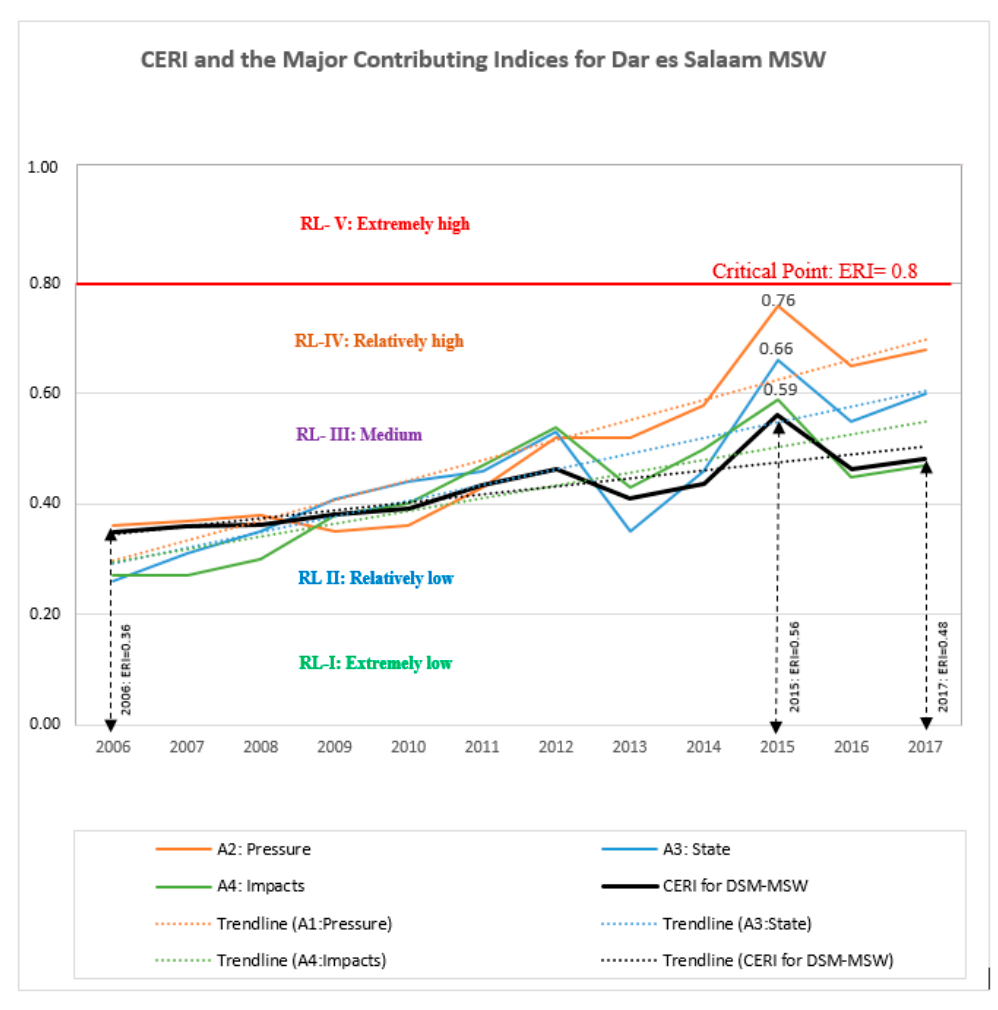
Figure 10. CERI and the Major Contributing Indices for Dar es Salaam MSW.